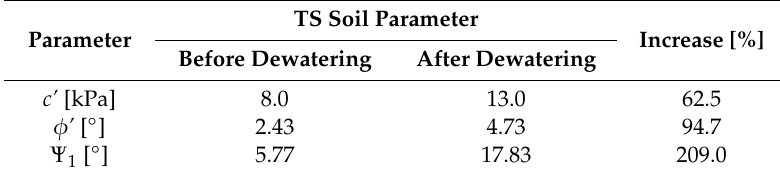
Table 1. The e ff ect of increases in parameters caused by vacuum dewatering.